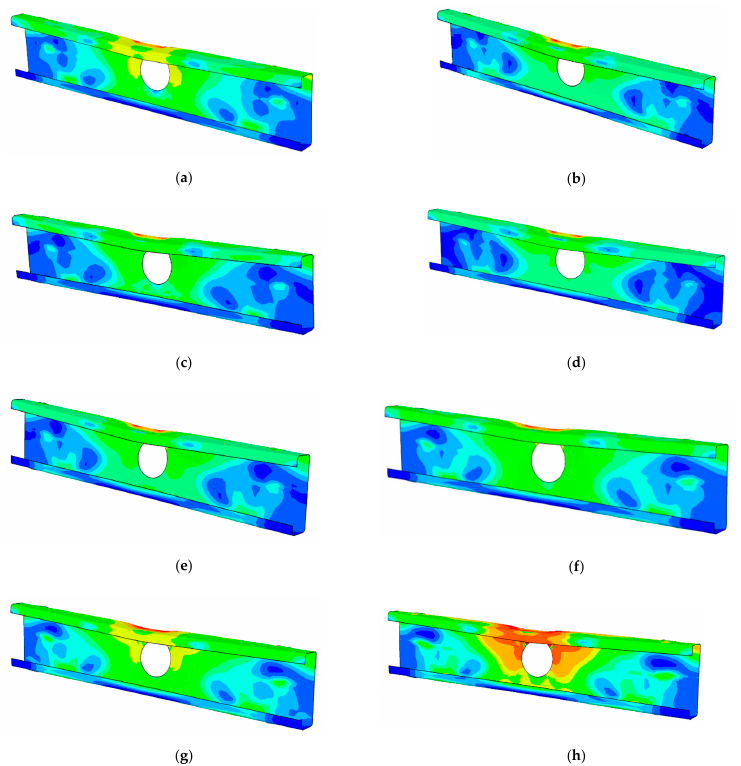
Figure 4. Failure modes of unfastened section (100 × 30 × 15 ‐ t1.55 ‐ N50 ‐ A0.6 ‐ FR) with the centered hole at different tem ‐ peratures: ( a ) 20 °C; ( b ) 100 °C; ( c ) 200 °C; ( d ) 300 °C; ( e ) 400 °C; ( f ) 500 °C; ( g ) 600 °C; ( h ) 700 °C.